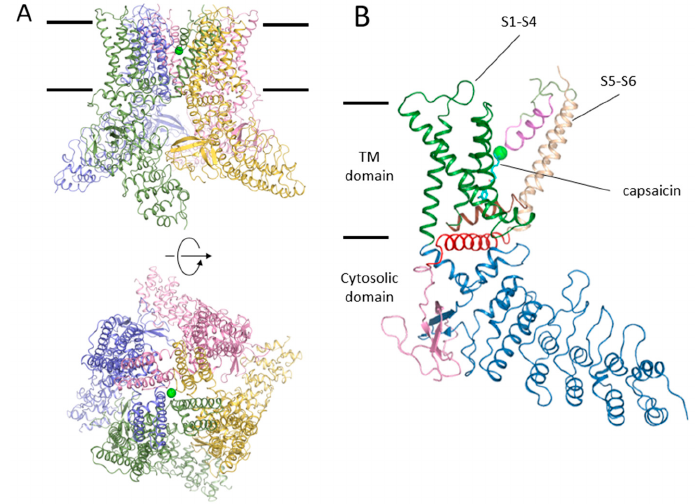
Figure 3. TRPV1 structure in complex with capsaicin (PDB code: 7LR0 [63]). Panel ( A ) shows the front (top) and top (bottom) global views of the channel, represented in colored cartoons. Black bars indicate the approximated location of the lipidic membrane. ( B ) Structural representation of TRPV1 domains. The illustration shows a single subunit colored differently for the distinct domains: cytosolic N-terminus ankyrin domain (sky-blue); S1–S4 voltage sensor-like domain (green); linker S4–S5 (brown); S5 and S6 (wheat); pore helix and selectivity filter (violet); sodium ion (sphere in green); TRP helix (red); and C-terminus (pink). Capsaicin at the binding site is colored in cyan. All figures have been obtained with PyMol (https://pymol.org/; accessed on 10 October 2022), version 2.5 open source.